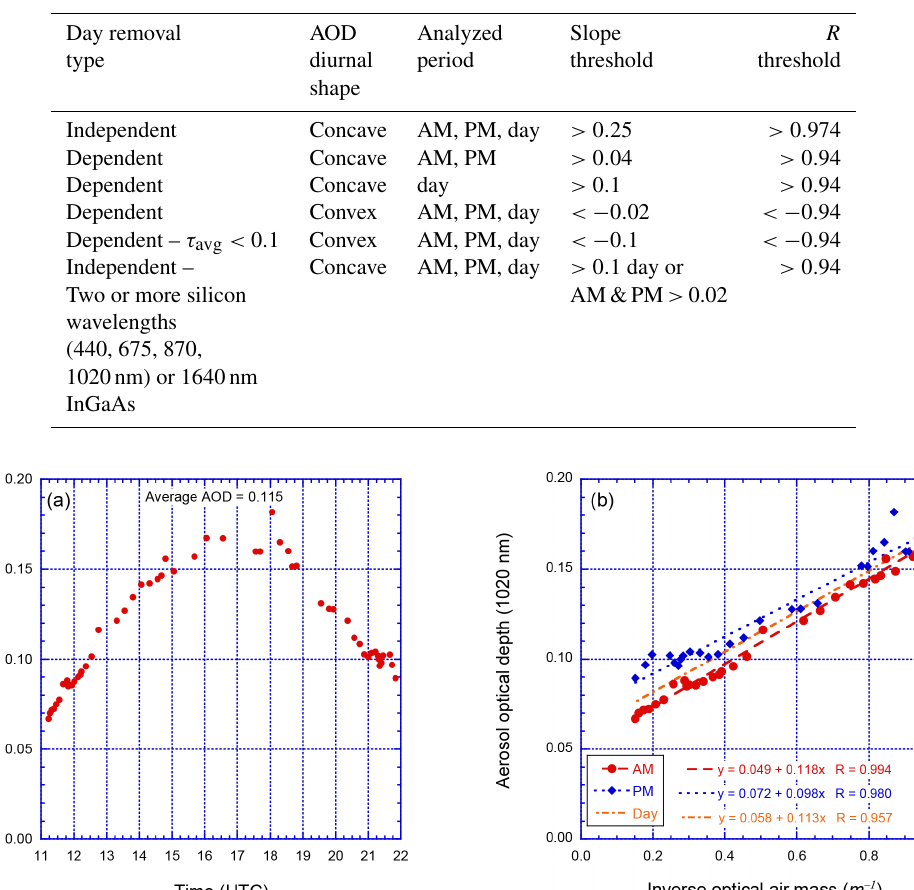
Table 4. Thresholds used to determine the independent and dependent AOD diurnal dependence. Satisfying both the slope and correlation coefficient ( R ) conditions would constitute the possible removal of all measurements for a day.